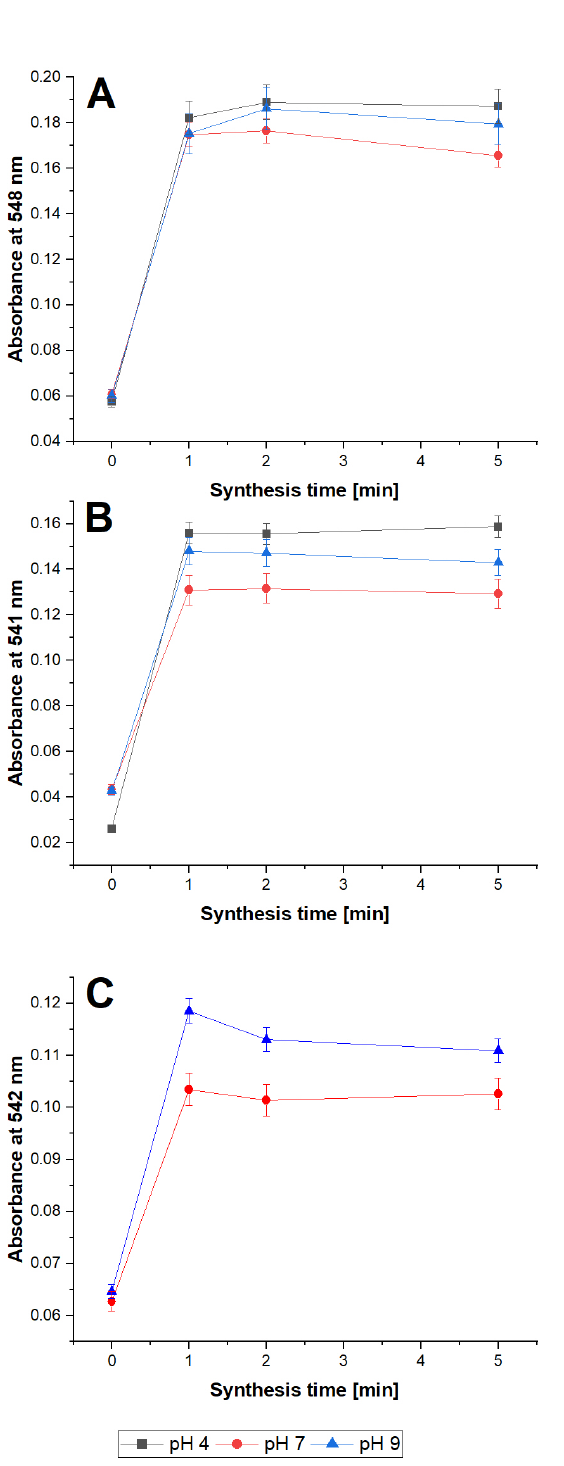
Figure 6. Microwave -assisted synthesis of Cu complex with: ( A ) TMPyP, ( B ) TSPP, ( C ) TCPP. [Cu 2+ ] = [TSPP] = [TMPyP] = [TCPP] = 10 −5 mol L −1 . [Cu 2+ ] = [TSPP] = [TMPyP] = [TCPP] = 10 − 5 mol L − 1